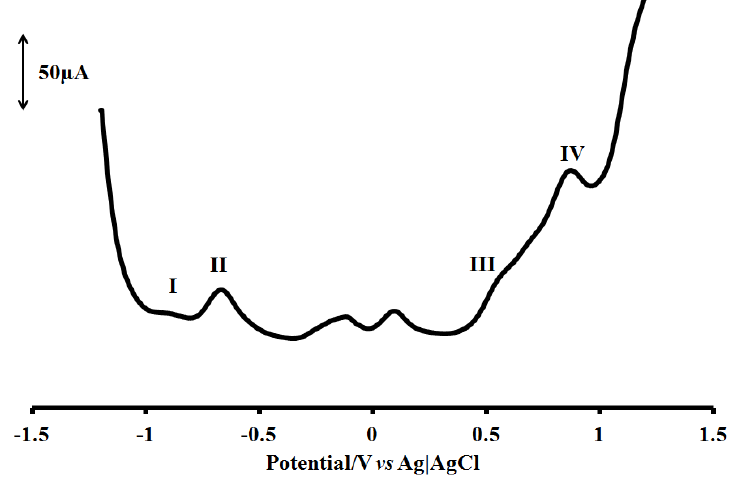
Figure 6. Square wave voltammogram for [RuL distilled DMF containing 0.1 M TBABF amplitude = 50 mV vs . Ag|AgCl, frequency = 10 Hz. Scan rate = 100 m Vs − 1 vs .